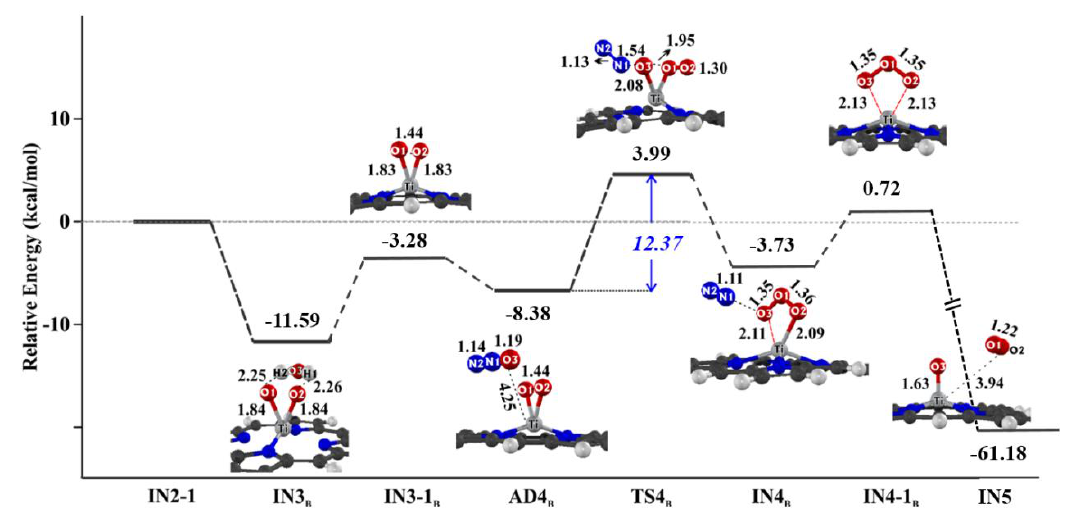
Figure 5. Path B: Water desorption followed by the second N 2 O decomposition and oxygen formation.